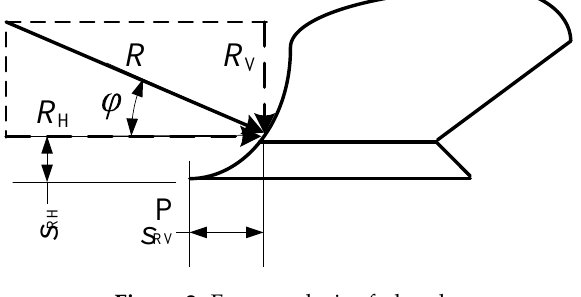
Figure 2. Force analysis of plough.